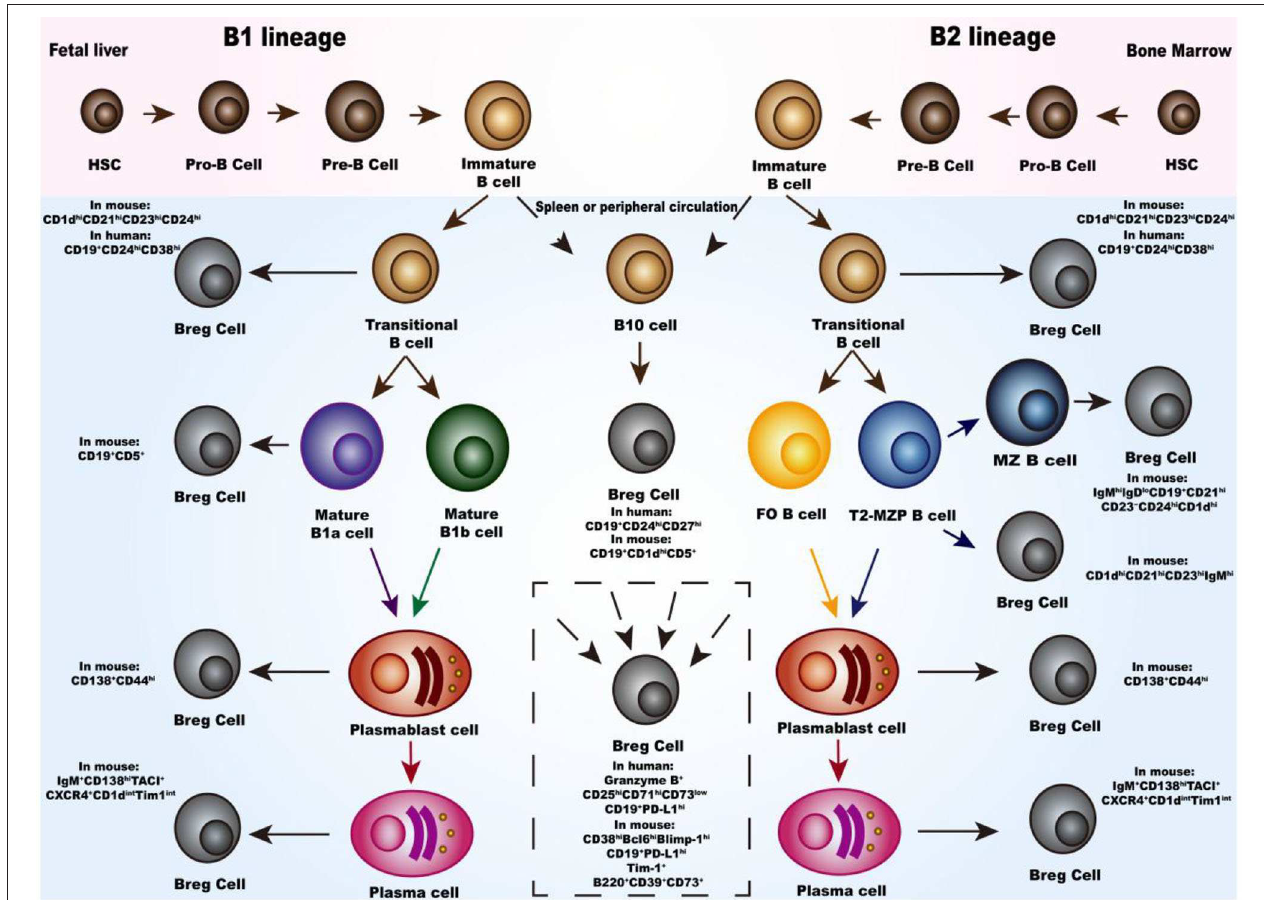
FIGURE 1 | Development and differentiation of Breg cells. In bone marrow or fetal liver, hematopoietic stem cells (HSC) differentiate through progenitor B cells (Pro-B), precursor B cells (pre-B), immature B cells and transitional B cells. For the B1 subset, migrating to the spleen or peripheral circulation, the transitional B cells differentiate into either mature B1a cells or mature B1b cells and eventually differentiate into plasmablast cells and plasma cells. Meanwhile, for the B2 subset, the transitional B cells differentiate either into follicular (FO) or marginal zone (MZ) B cells and eventually into plasmablast cells and plasma cells. Moreover, there is the transitional-2 marginal-zone precursors (T2-MZPs) B cells stage which is the precursor of MZ B cells. Studies have proved that the transitional B cells, MZ cells, T2-MZP cells, B1 cells, plasmablasts, and plasma cells can all differentiate into Breg cells with different phenotypes. Differentiation pathway of B10 cells in the middle of the photograph are listed separately because there are still not enough studies to classify them. In the dotted box, there are Breg cells with different phenotype and the source of them are still not